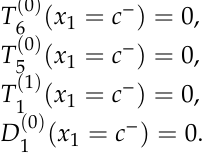
Figure 4. Thickness-shear (TSh) strain distribution (   1 1 u ) near resonance.